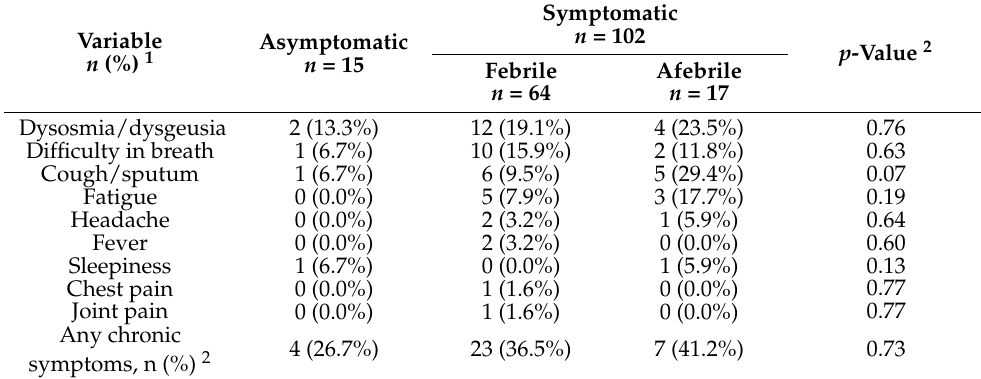
Table 3. Post-discharge questionnaire survey stratified by three Table 3. Post ‐ discharge questionnaire survey stratified by three groups.